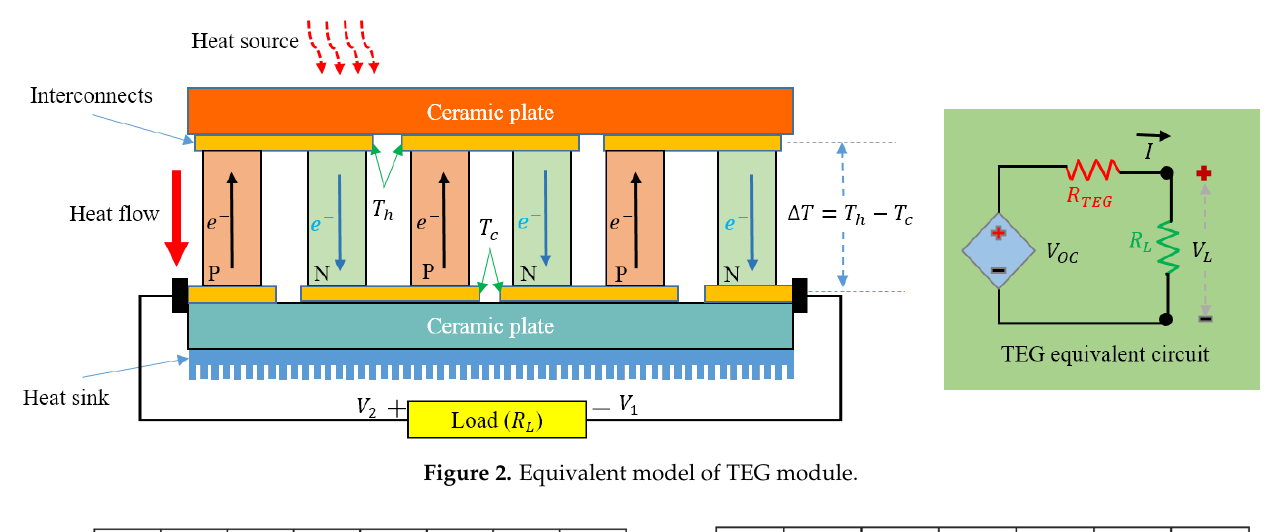
Figure 2. Equivalent model of TEG module.